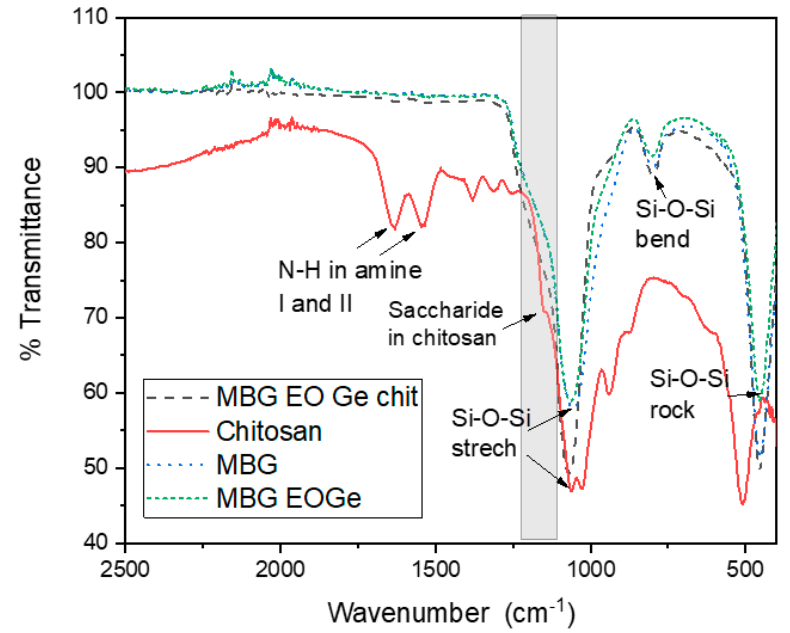
Figure 5. ATR-FTIR characterization of the mesoporous bioactive glass particles (MBG) with Melaleuca armillaris EO (MBG EO, with EO and gentamicin (MBG EOGe), and with EO and gentamicin cover with chitosan (MBG EOGe chit). Also, chitosan was analysed.